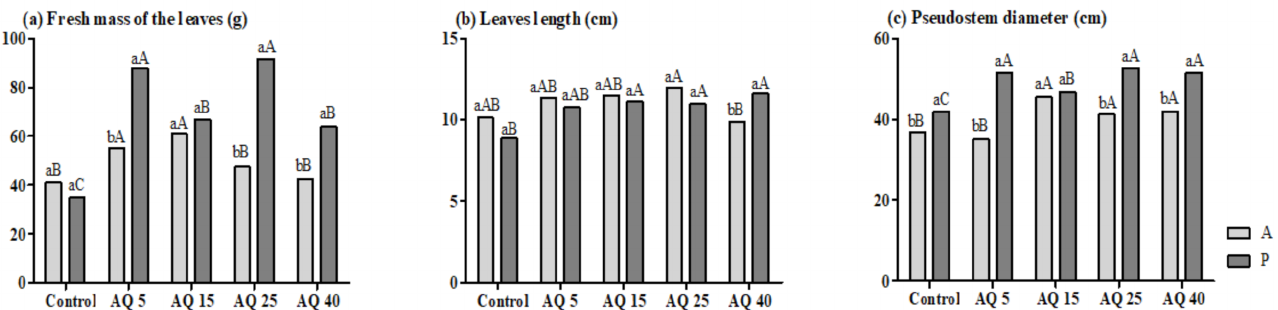
Figure 1. Fresh mass of the leaves ( a ), leaf lengths ( b ), pseudostem diameter ( c ) of onion plants of the Alvar á and Perfecta cultivars at 90 DAT (days after transplanting) submitted to foliar sprays of biomass suspensions of microalgae A. quadricellulare at different concentrations. Treatments: 0 g L − 1 (control); 0.05 g L − 1 (AQ 5); 0.15 g L − 1 (AQ 15), 0.25 g L − 1 (AQ 25); 0.4 g L − 1 (AQ 40). Onion cultivars (A = Alvar á , P = Perfecta). Lower-case letters in the column: cultivars; upper-case letters in the column: treatments. Means followed by the same letter in the same column do not differ statistically ( p < 0.05) according to Tukey’s test ( n =